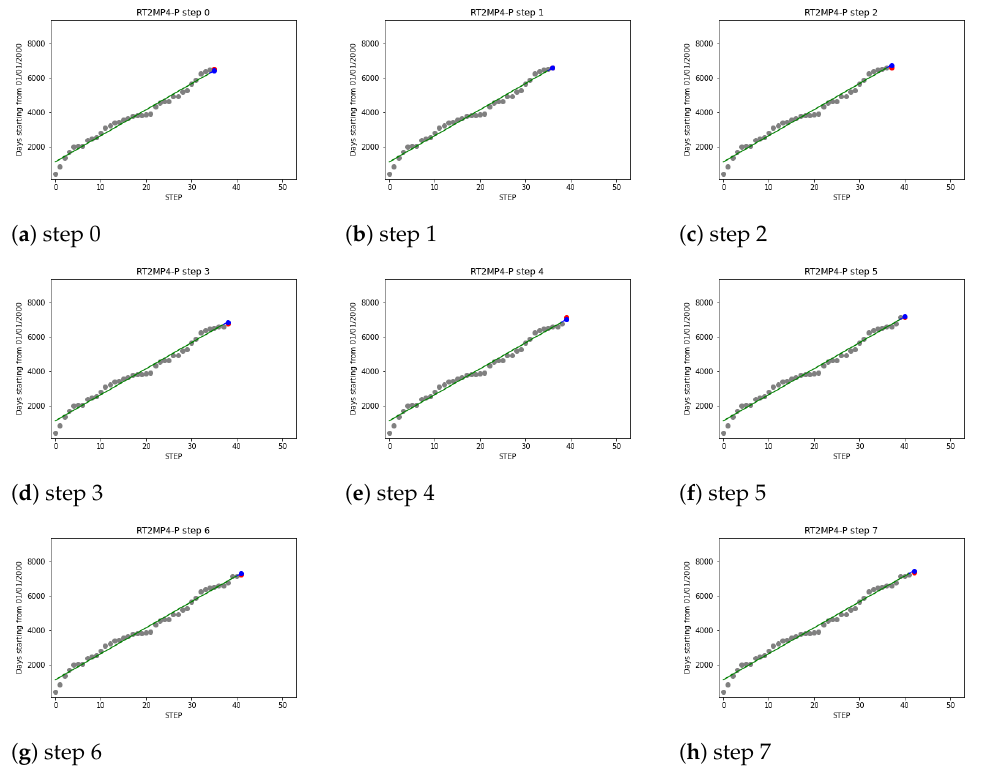
Figure 8. Step by step predictions performed by the linear regression model of the RT2MP4-P component. Table 12. Results table of the RT2MP4-P component performed by the linear regression